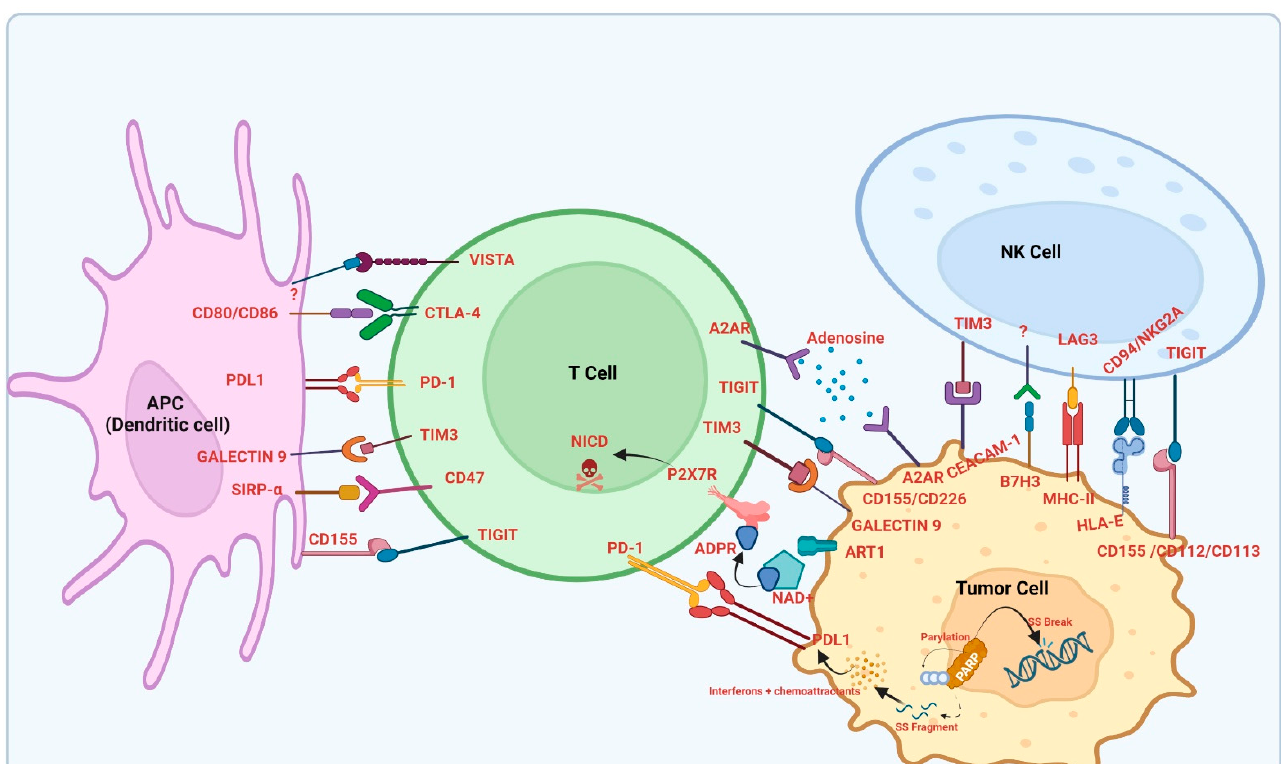
Figure 1. Key immune checkpoint targets for cancer immunotherapy mentioned in this review. Immune checkpoint inhibitors (ICIs) and their respective ligands are reported in the context of the tumor immune microenvironment (TME). Various immune checkpoint target-mediated interactions between immune cells such as dendritic cells (DC) (serving as APCs), T cells, NK cells, and tumor cells are shown here. Mechanisms of action of all the checkpoint proteins mentioned here have been elaborated in their respective sections in this review. ICIs targeting these immune checkpoints are currently used in clinic or under pre-clinical or clinical investigation. The “?” indicates interactions which are unknown/uncertain. This figure has been created with BioRender.com, access date 22 January 2023.